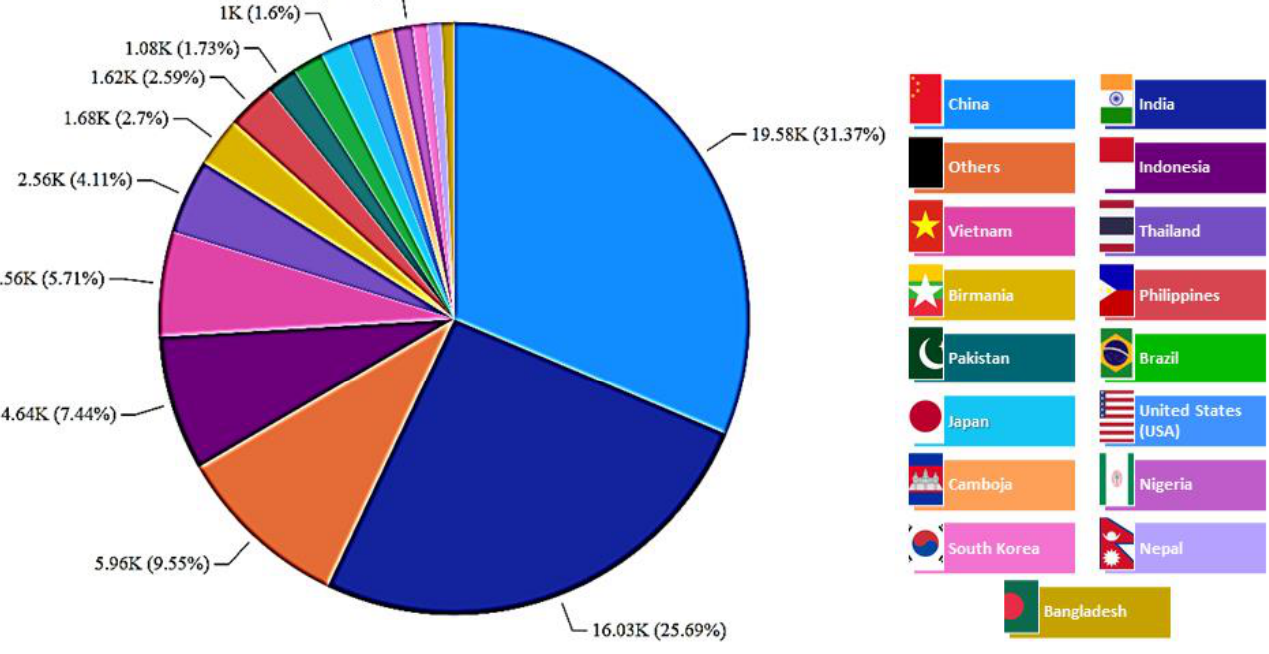
Figure 6. World distribution of cellulosic waste production from rice (thousand metric tons).